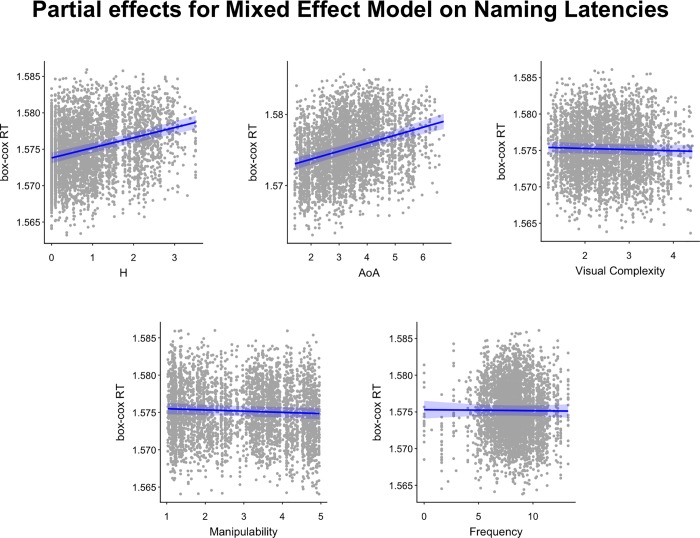
Partial effects of the mixed models on naming latencies.The figure shows the partial effects for the regression model on naming latencies. Each panel represents the partial effect of a predictor included in the regression. The blue line represents the regression line for that partial effect. The shaded blue area represents the area delimiting the standard error of the estimate. Gray points indicate the partial residuals associated with the predictor.